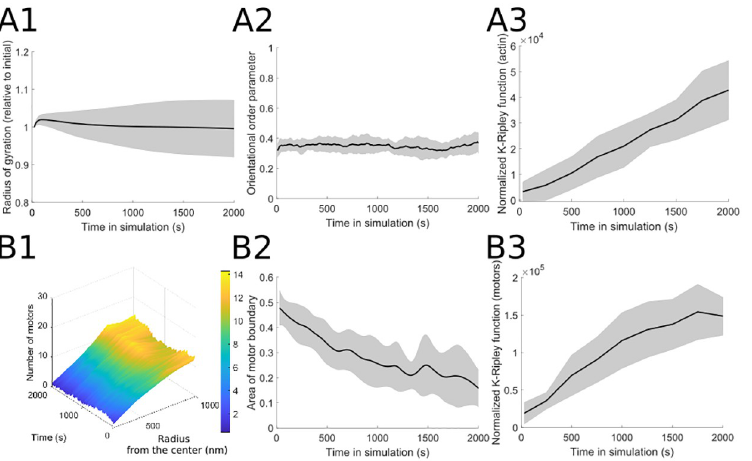
Fig 3. Additional measures to characterize (A) actin filament and (B) motor protein organization in simulations using baseline parameter values (Table 1). (A1) The radius of gyration, a measure of filament network contractility (§ 5.1), shows little change over time but with high variability around the mean. (A2) Similarly, the orientational order, indicating the degree to which actin filaments are aligned over the whole domain (§ 5.2), shows little change over time with the baseline parameter values. (A3) The normalized K-Ripley function, a spatial statistic measure which indicates the extent of uniformity in the spatial distribution of filaments (§ 5.7), increases over time reflecting the increasingly clustered filament organization. (B1) Myosin motor distribution is visualized over time as a function of the distribution of radial distances from the center of the domain (§ 5.4), indicating a higher density of motors at the periphery of the domain. (B2) The area of motor boundary, determined by the minimum polygon that encloses all motors on the domain (§ 5.5), decreases over time reflecting the increased clustering of both filaments and motors. (B3) As in panel (A3), the normalized K-Ripley function for the myosin motors increases over time as a result of increased filament and motor clustering. The parameter values used are d step = 6 nm, k head.bind = 0.2/s, F s = 100 pN, range heads = 15–30 (see Table 1). Solid lines indicate the average and shaded areas indicate the standard deviation over 10 independent stochastic runs. See Fig 2 for simulation snapshots and further measures of actin filament organization.